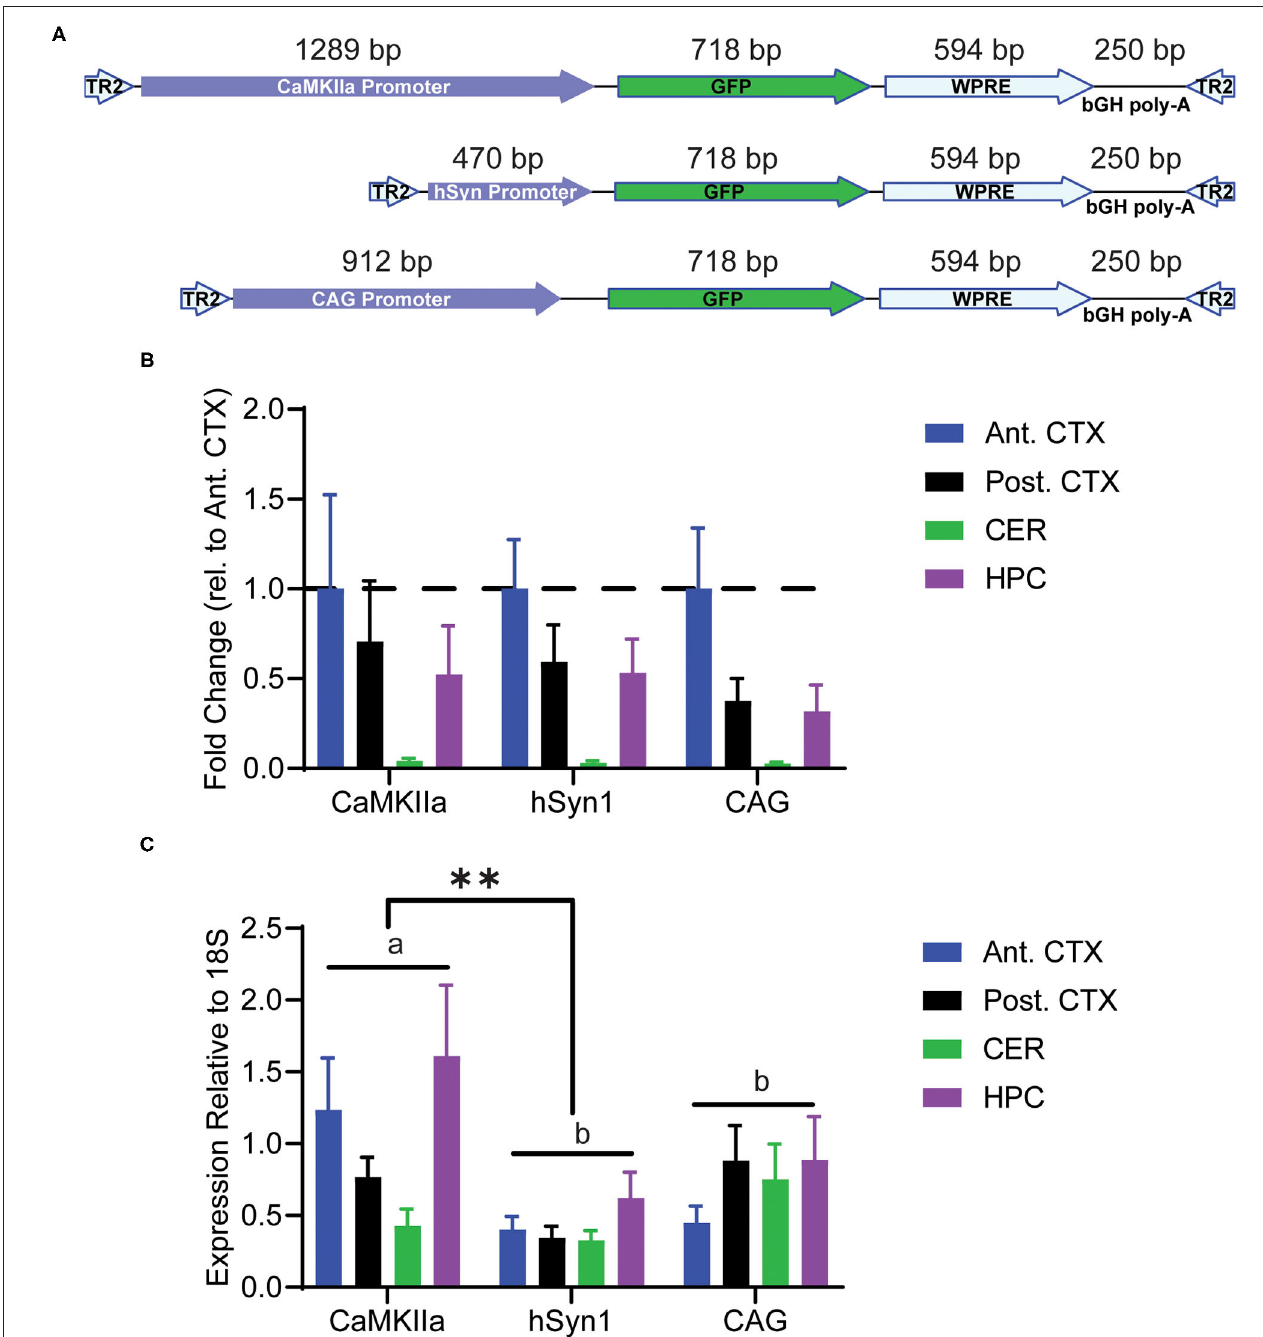
FIGURE 2 | Transduction of discrete brain regions. Mice were injected with PHP.eB-GFP driven by either the CaMKII α , hSyn1, or CAG promoters and tissue was collected 4 weeks later. (A) Schematic of the AAV constructs. (B) Graph of viral genomes per mouse genome. A main effect of brain region was observed by two-way ANOVA. (C) Graph of GFP RNA expression relative to 18S rRNA assayed by RT-qPCR. Data are presented as mean ± SEM ( n = 4). A main effect of promoter was observed with CaMKII α driving significantly greater overall expression than hSyn1. **denotes p < 0.001 by two-way ANOVA and Tukey’s post-hoc test. Bars annotated with the same lower-case letter are not statistically significant from each other. CaMKII α , calmodulin dependent protein kinase II α ; hSyn1, human synapsin 1; Ant. CTX, anterior cortex; Post. CTX, posterior cortex; CER, cerebellum; HPC, hippocampus.